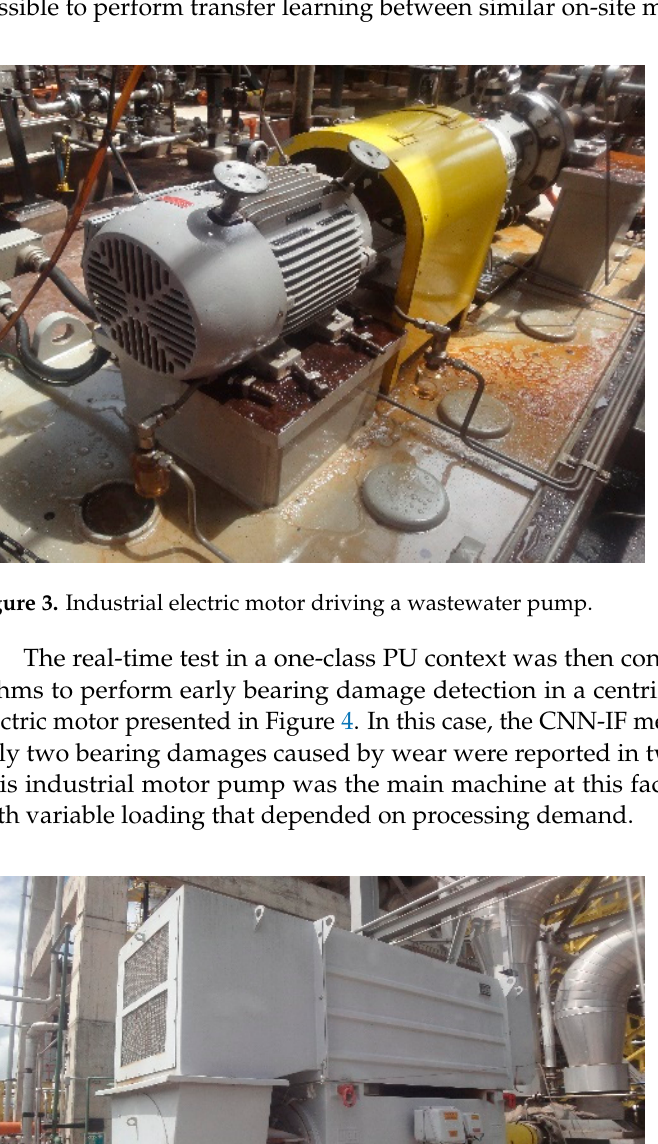
Figure 3. Industrial electric motor driving a wastewater pump.